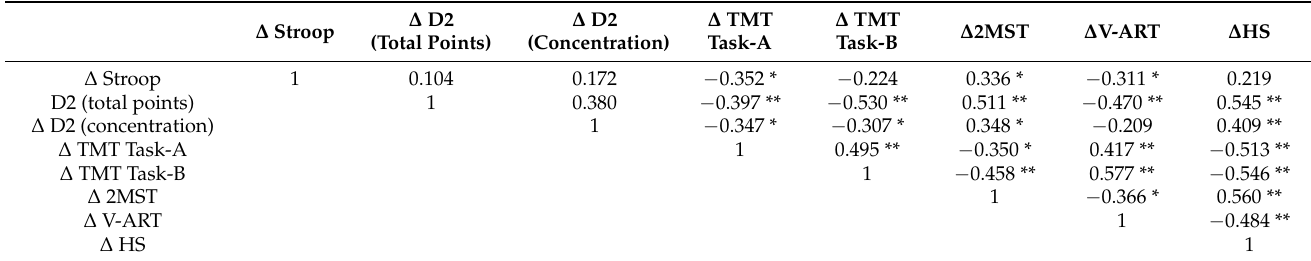
Table 4. Correlation analysis between physical and cognitive variables with measure increment after